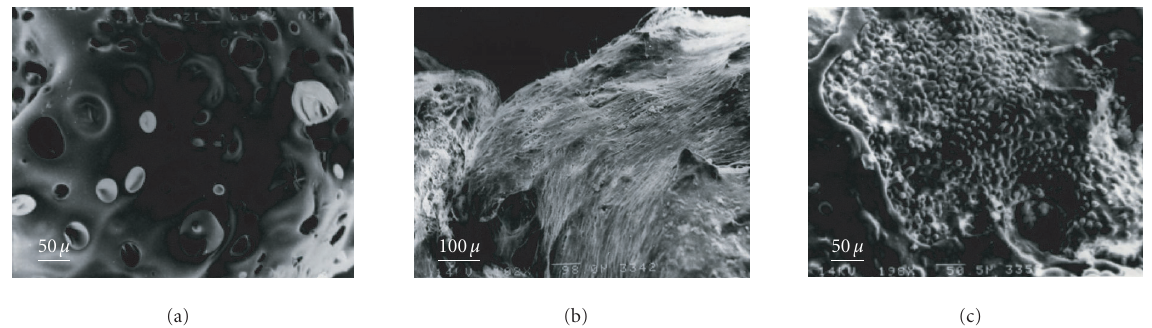
Figure 6. Scanning electron micrographs of sca ff old seeded and unseeded with osteogenic cells and incubated in mineralization medium. (a) Unseeded sca ff old. (b) Seeded sca ff old after 2 weeks of incubation. (c) Seeded sca ff old after 4 weeks of